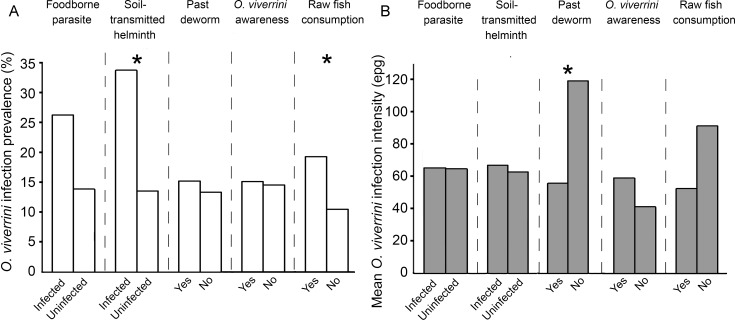
Other parasitic infections and human attitude and behavior as risk factors for O. viverrini infection.Association of (A) O. viverrini infection prevalence and (B) mean infection intensity with participants of other infections, deworming history, awareness, and raw fish consumption behavior. Significant differences in infection prevalence or intensity for bivariate analyses are indicated by the asterisks.